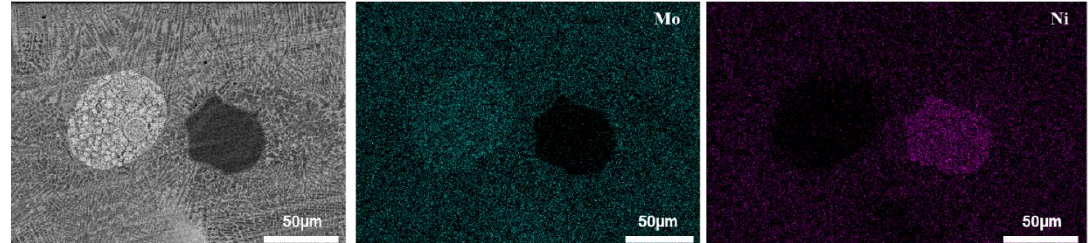
Figure 5. EDS elemental map of Nickel and Molybdenum accumulations in the as processed (AP) T800 + 20% NiCr alloy.